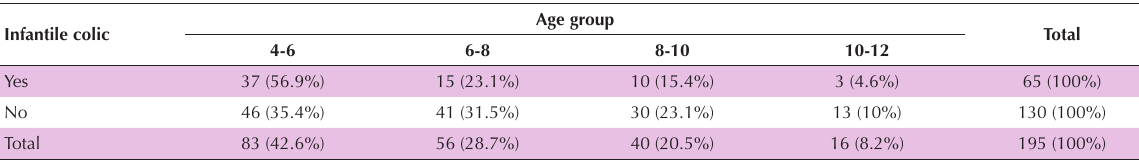
Table 3. Determination of infantile colic frequency by the infant age Infantile colic